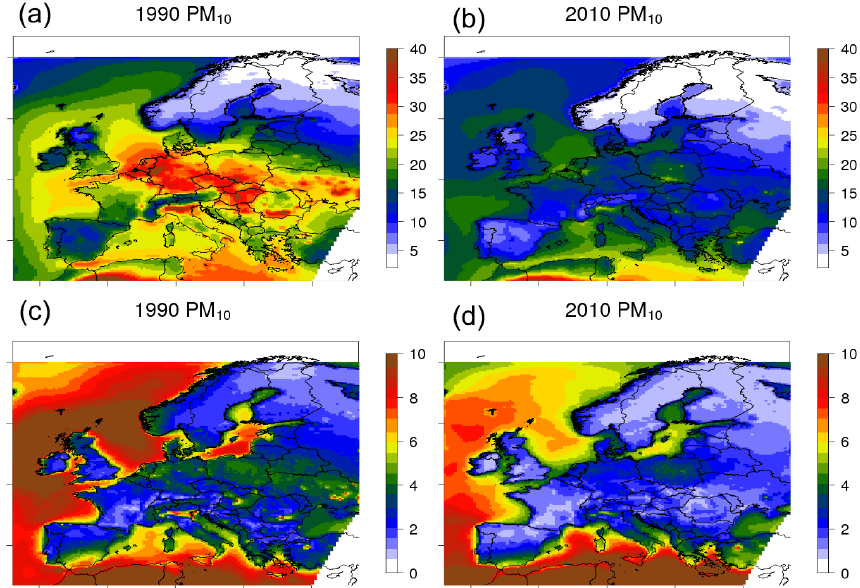
Figure 5. Eight-models ensemble results for 1990 (a, c) and 2010 (b, d) for annual mean PM 10 (µgm − 3 ) . (a, b) Ensemble median, (c, d) en- semble spread (standard